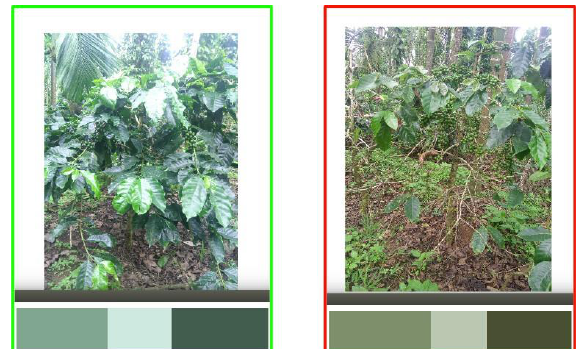
Figure 1. System Design